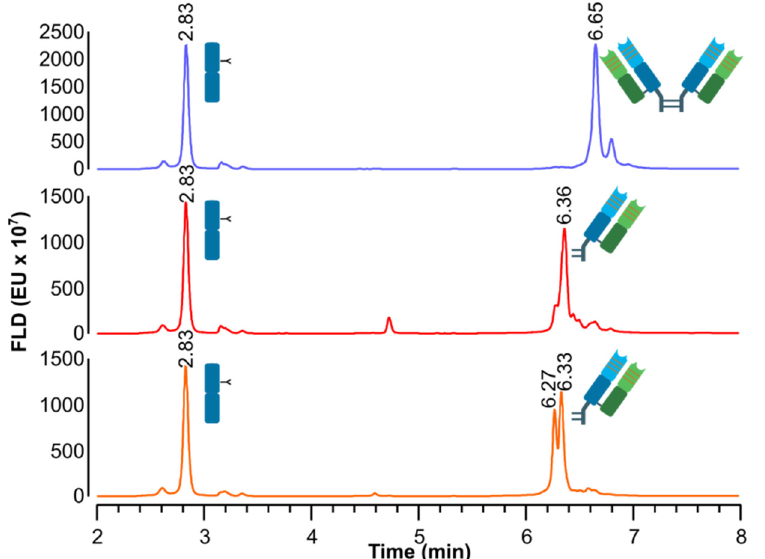
Figure 2. RPLC fluorescence chromatograms of IdeS -digested bevacizumab (blue), IdeS -digested bevacizumab, reduced with DTT (red) and IdeS -digested bevacizumab, reduced with β -MEA (or- ange).